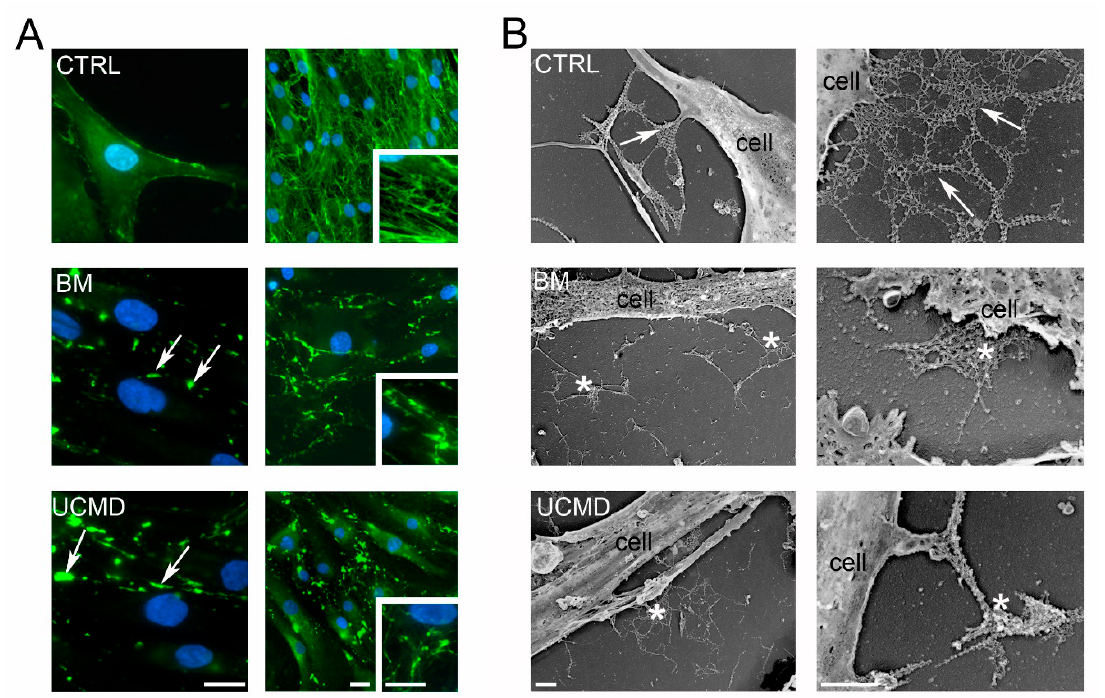
Figure 1. Collagen VI expression in tendon primary cultures of Bethlem myopathy (BM) and Ullrich congenital muscular dystrophy (UCMD) patients. ( A ) Immunofluorescence analysis of collagen VI (green) in proliferating (left panels) and confluent (right panels) tendon cultured fibroblasts from control (CTRL), BM, and UCMD patients. A clear cell membrane association of collagen VI is detectable in normal proliferating cells, while confluent cultures display a filamentous arrangement